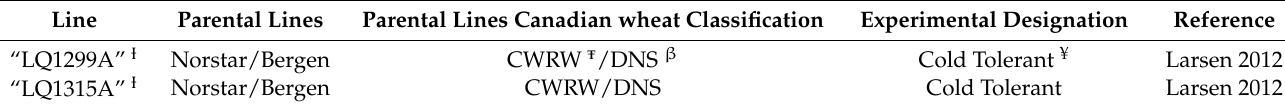
Table 3. Least square means for grain yield, grain quality, and select agronomic parameters affected by ultra-early plant- ing. Table 2. Classification of cold tolerant lines, and parent lines.